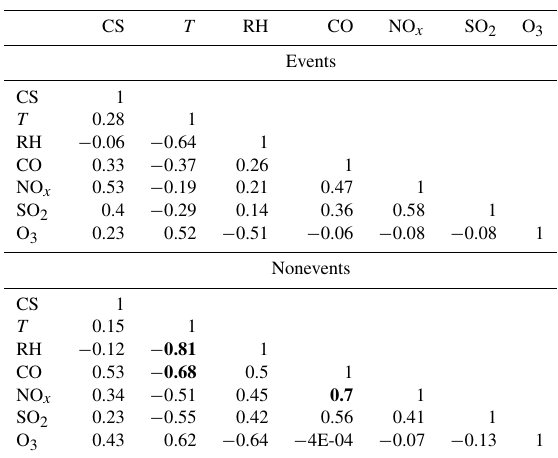
Table 1. Correlation coefficients between different meteorological parameters, gas concentrations and condensation sink (CS) during clear-sky events and nonevents during spring (March–May, 1996– 2015) and time window 09:00–12:00. High positive and negative correlations are marked in